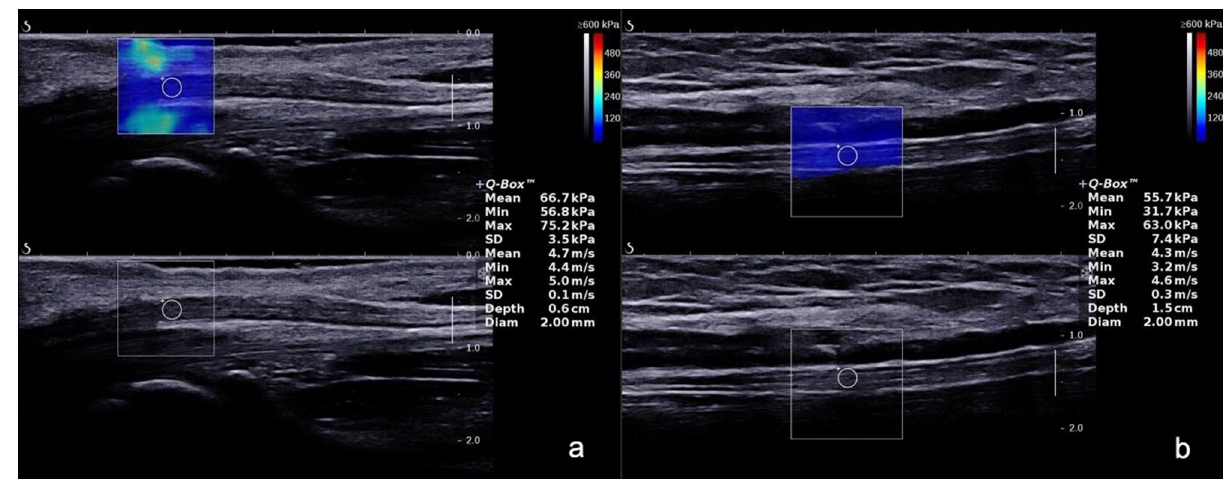
Figure 4. In the relaxed position, the shear wave velocity of the median nerve at the carpal tunnel ( a ) and the tibial nerve at the tarsal tunnel ( b